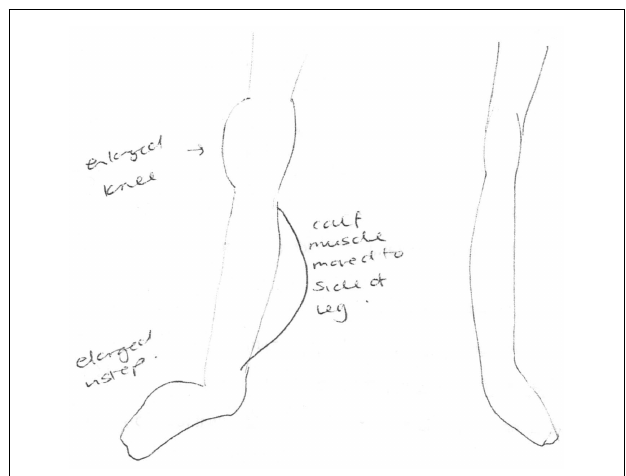
FIGURE 1 | Clinician’s drawing from description provided by participant 2 as part of the Bath CRPS Body Perception Disturbance Scale . Notes on the drawing are: “enlarged knee,” “enlarged instep,” and “calf muscle moved to side of